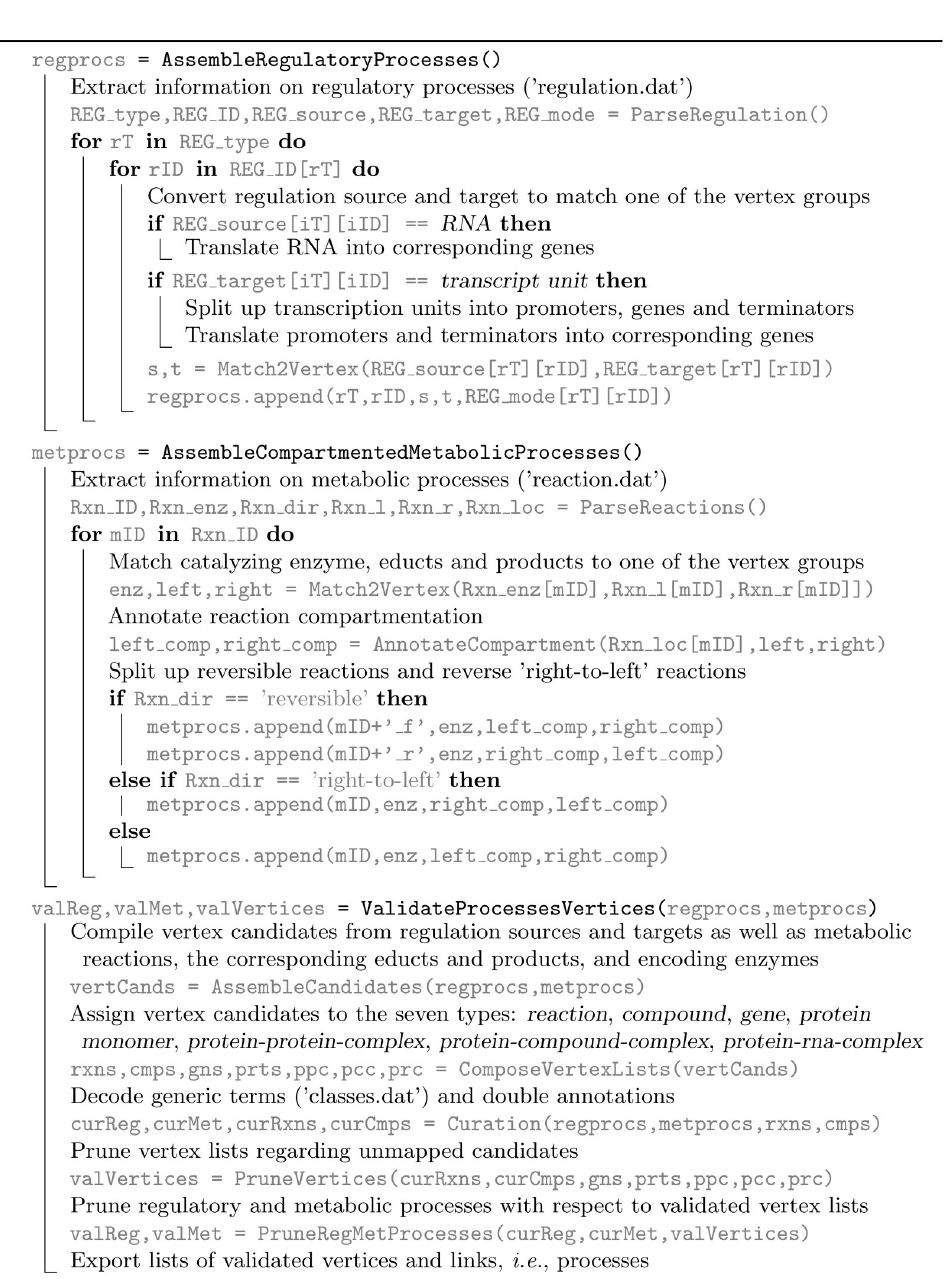
Fig 9. Algorithm 1. Extraction of database information (EcoCyc, release 20.0) on regulatory and metabolic processes.